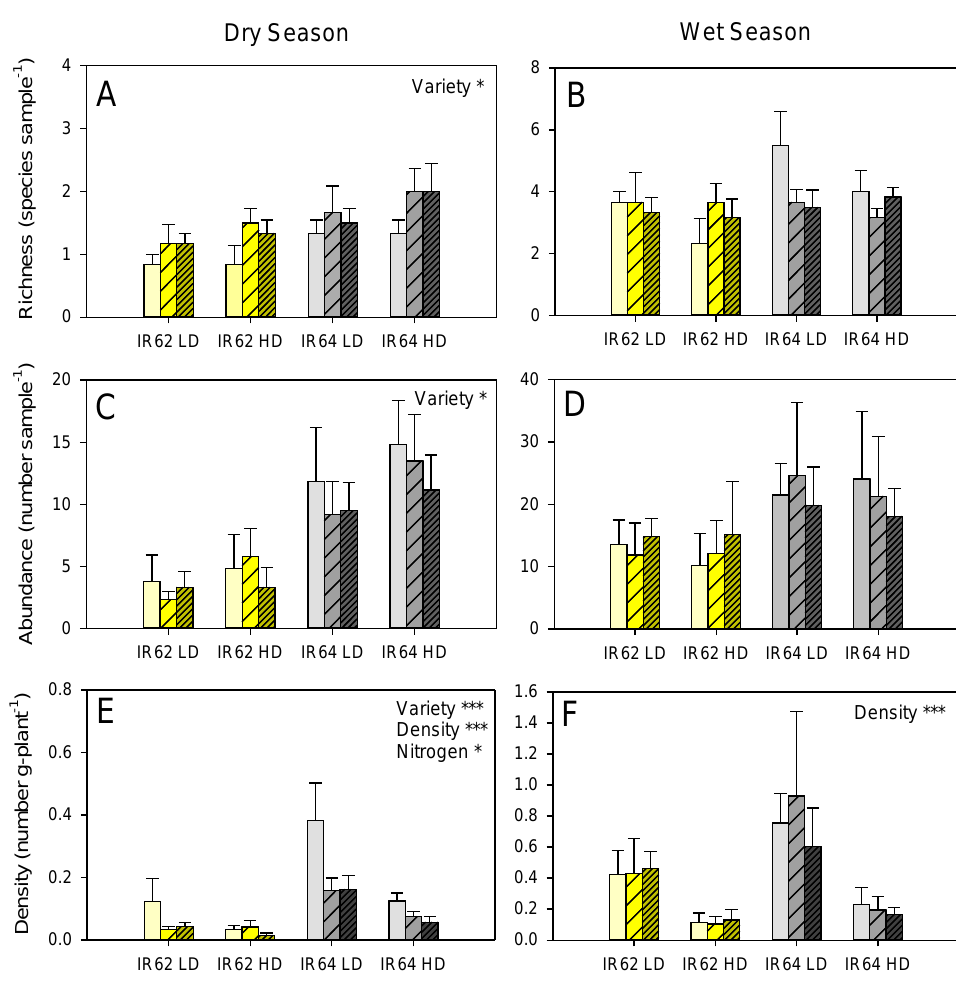
Figure 2. Species richness ( A , B ), abundance ( C , D ), and density ( E , F ) of leafhoppers (all species combined: Table S1) in rice plots with resistant (IR62: yellow bars), and susceptible (IR64: grey bars) rice transplanted at low (LD) and high (HD) densities under varying nitrogen fertilizer treat- ments. Nitrogen was applied at 0 Kg ha − 1 (open bars), 60 Kg ha − 1 (hatched bars) and 150 Kg ha − 1 (densely-hatched bars). Factors that significantly affected leafhopper parameters are presented with significance levels as * p ≤ 0.05 and *** p ≤ 0.005. Sampling was conducted during the dry ( A , C , E ) and wet ( B , D , F ) seasons using blow-vac samplers. Standard errors are indicated ( N = 6).